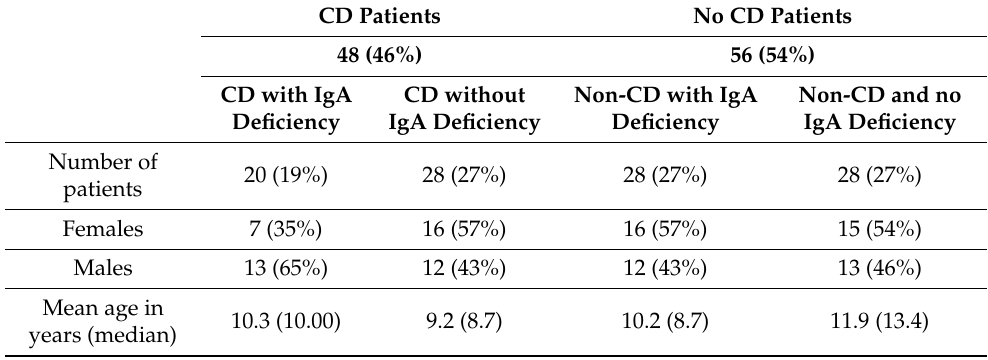
Table 1. Patients’ characteristics.